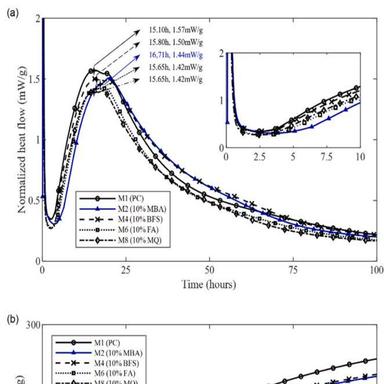
Flow diameters of mortar mixtures with different substitute materials (Results were taken as the average of two measurements, the error bar represents the standard deviation).